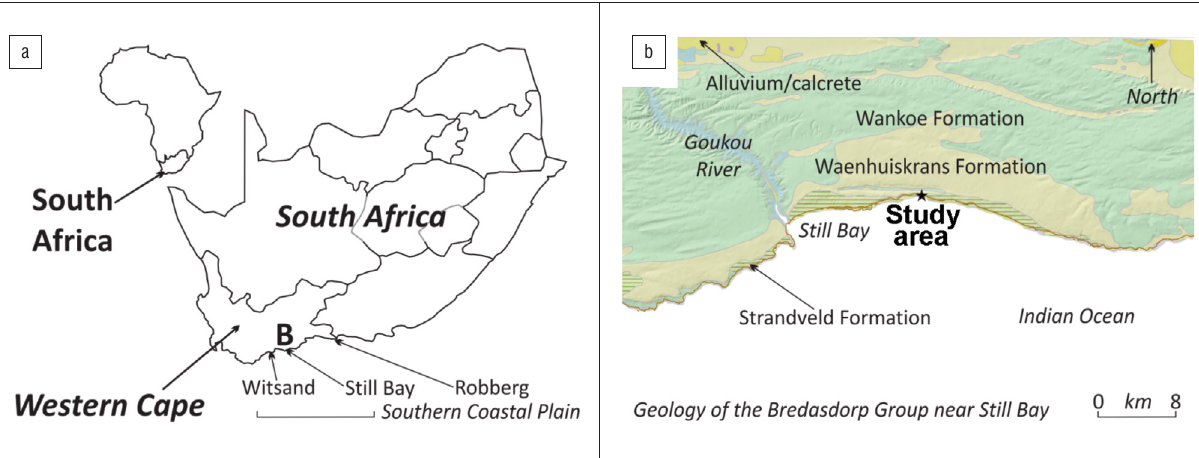
Figure 1: (a) Location of the study area within the Western Cape Province of South Africa. (b) Geological deposits in this region are dominated by strata of the Bredasdorp Group; the coastal deposits constitute outcrops of the Waenhuiskrans Formation, draped by Strandveld Formation unconsolidated